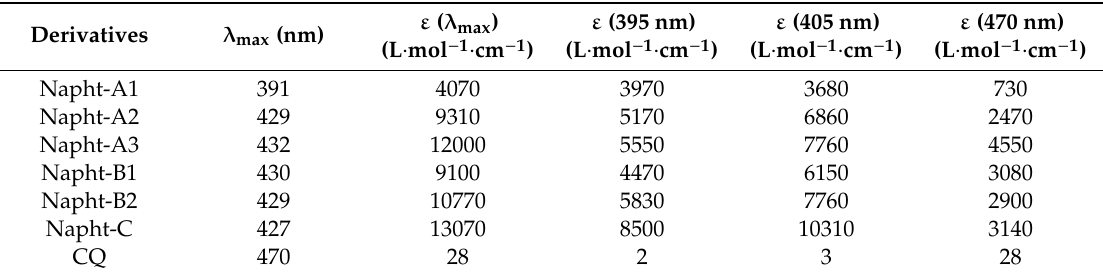
Table 1. Maximum absorption wavelengths (in the near visible range) and associated extinction coe ffi cients and molar extinction coe ffi cients for the investigated compounds at the wavelengths of the di ff erent light-emitting diodes (LEDs) used (in acetonitrile).